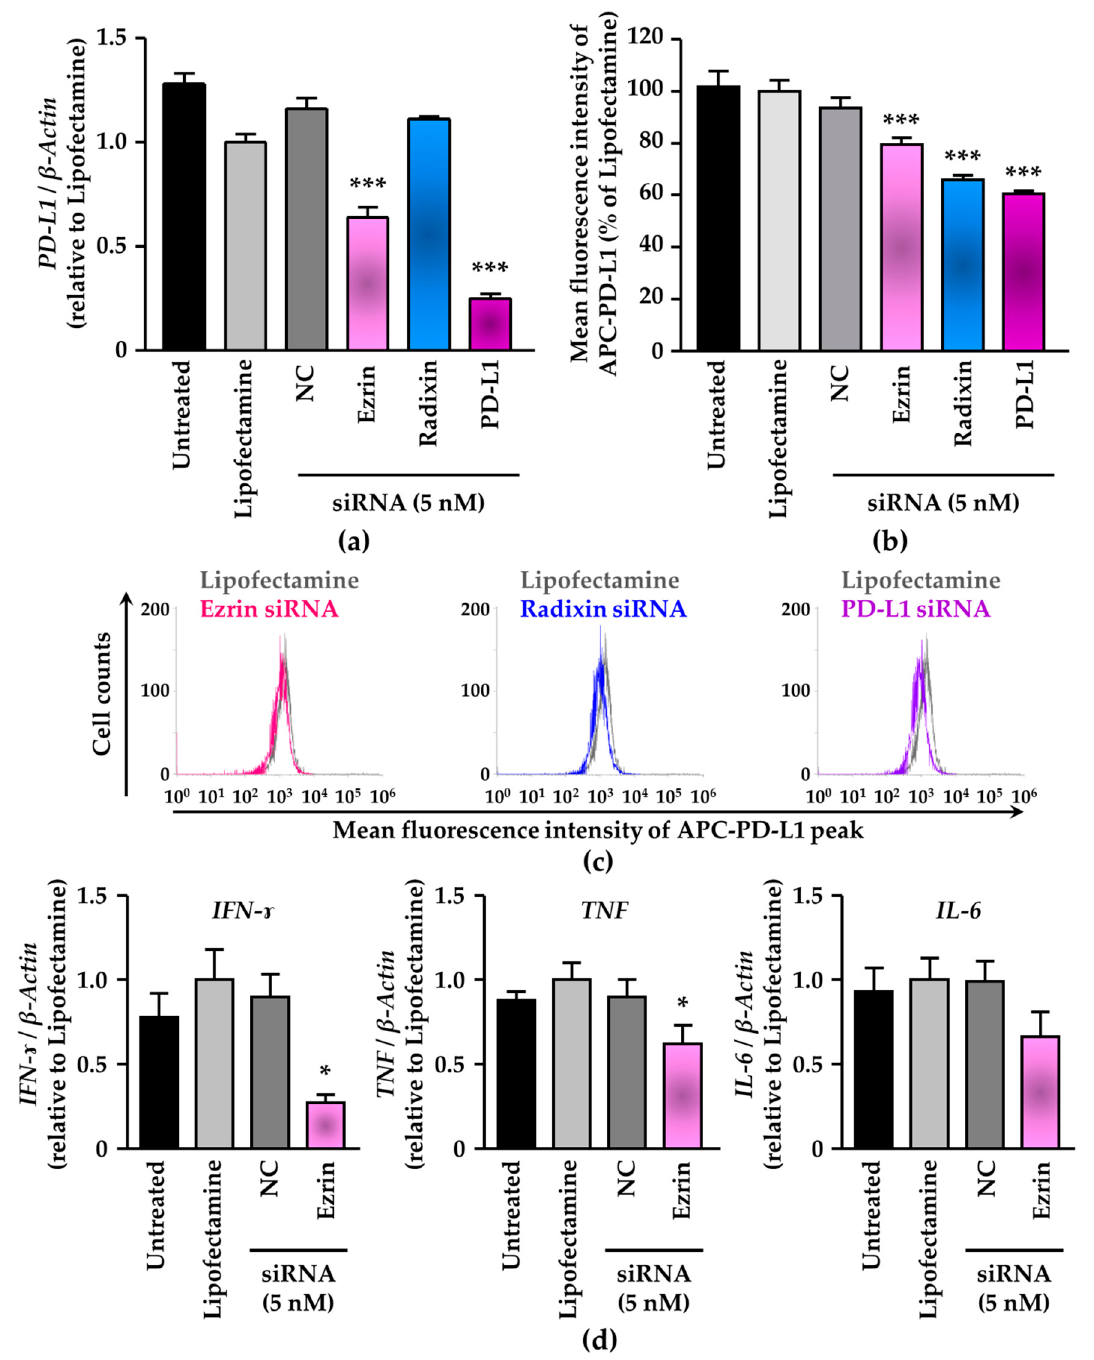
Figure 5. Effect of siRNAs targeting ezrin and radixin, or the programmed death ligand-1 (PD-L1) on the mRNA and cell surface expression of PD-L1 in KP-2 cells. ( a – c ) Cells were incubated with the transfection medium (Untreated), transfection reagent (Lipofectamine), non-targeting control (NC) siRNA, and specific siRNAs for ezrin, radixin, or PD-L1 and then cultured for 4 days to measure the mRNA and the cell surface expressions of PD-L1 protein. ( a ) The mRNA expression level of PD-L1 normalized with β -Actin in cells from all treatment group relative to that from Lipofectamine alone was determined by real-time reverse transcription (RT)-polymerase chain reaction (PCR); n = 3, *** p < 0.001 vs. Lipofectamine. All data were expressed as the mean ± SEM and analysed by